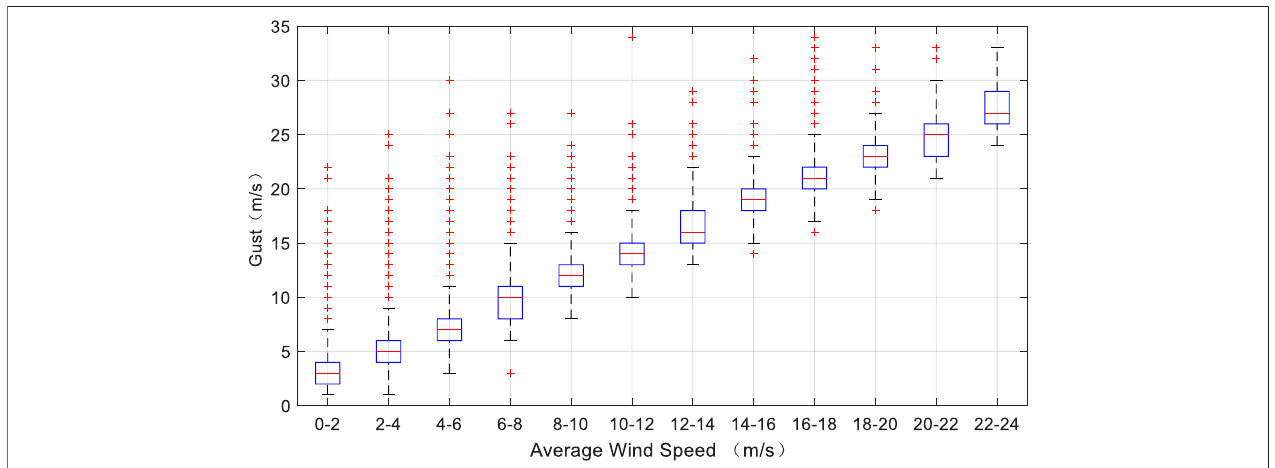
FIGURE 2 | Boxplots of average wind speed and wind gust from 2017 to 2019. The boxplot corresponds to the minimum, 25th percentile, 50th percentile (red lines), 75th percentile, and maximum values from bottom to top, respectively. Red crosses in the fi gure represent outliers that are more than 1.5 quartiles away from the 75th percentile or 25th percentile of the box.